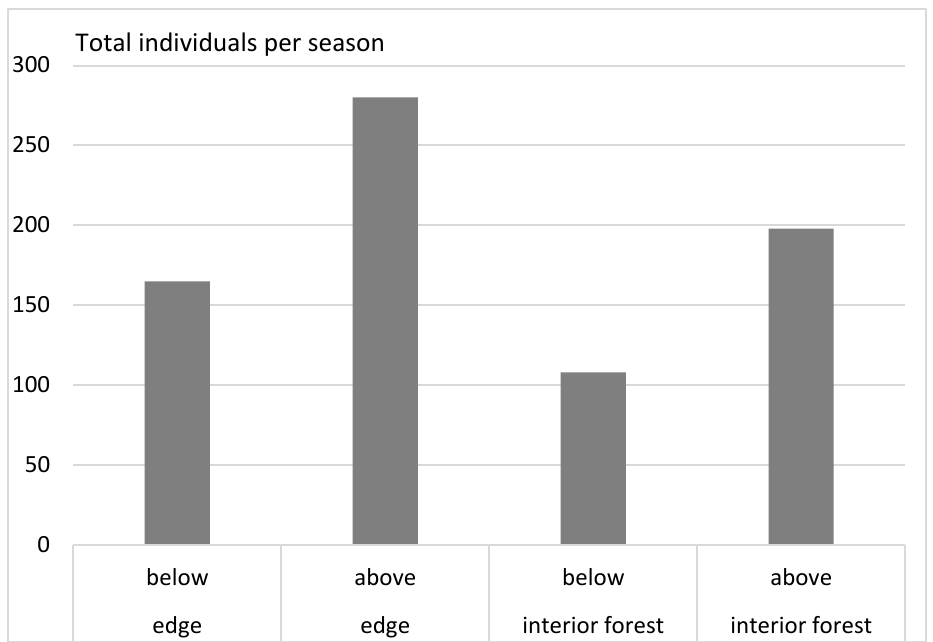
Figure 8. Lepidoptera cumulative abundance in glades and within the forest.